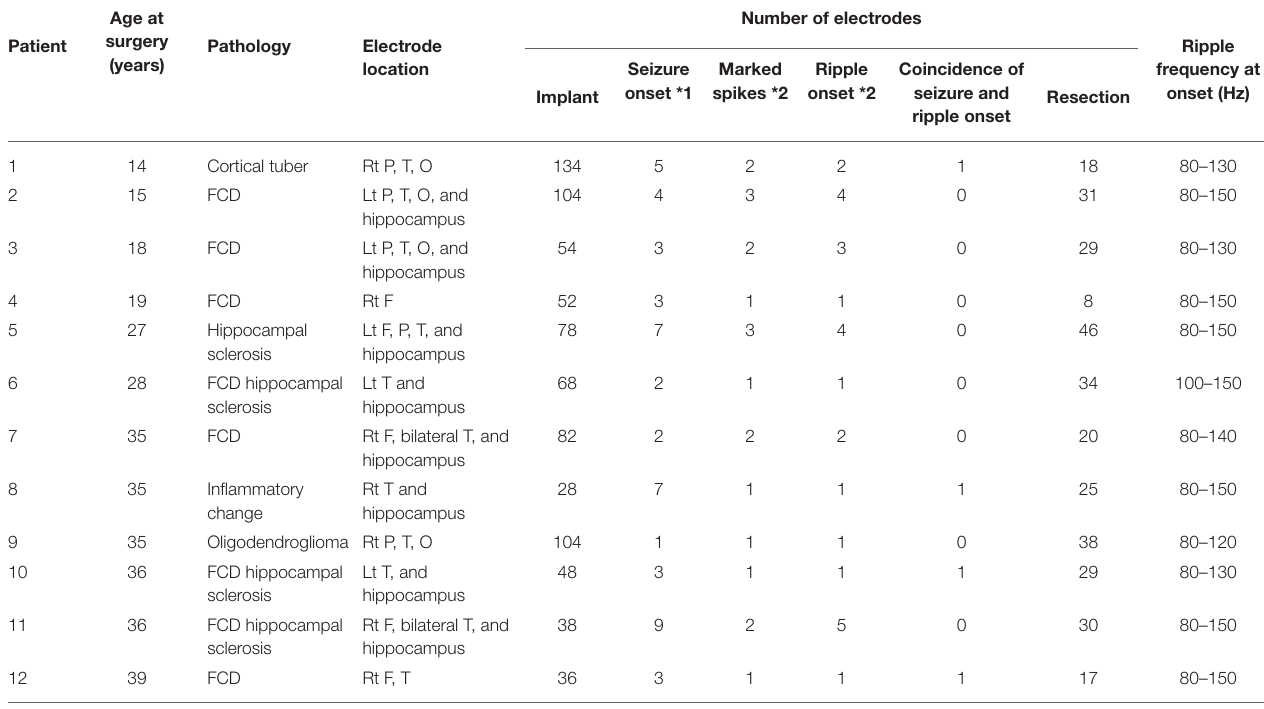
TABLE 1 | Patients’ characteristics and implanted electrodes data.